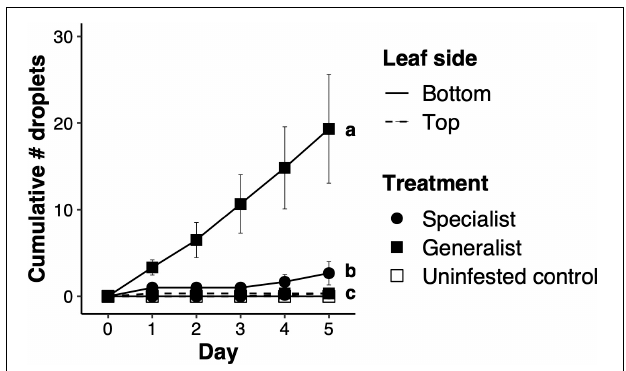
FIGURE 1 | Production of sticky droplets on honeysuckle leaves upon spider mite herbivory. Total number of sticky droplets [mean ± one standard error of the mean (SEM)] exuded on either surface of honeysuckle leaves per consecutive day. “Specialist” and “Generalist” are field-derived lines representing the honeysuckle race of Tetranychus urticae and a generalist conspecific, respectively. Leaves either exposed the adaxial surface (“Top”) or the abaxial surface (“Bottom”). Letters next to symbols on day five indicate significant differences between